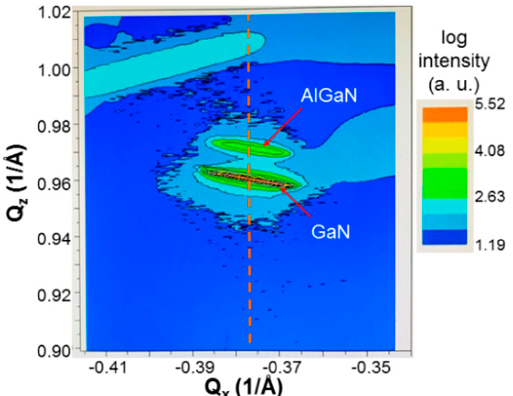
Figure 3. Reciprocal space mapping (RSM) result of sample uf-p. The vertical dashed line passing through the centers of the GaN and AlGaN features indicates that the AlGaN layer on the GaN template is fully strained.